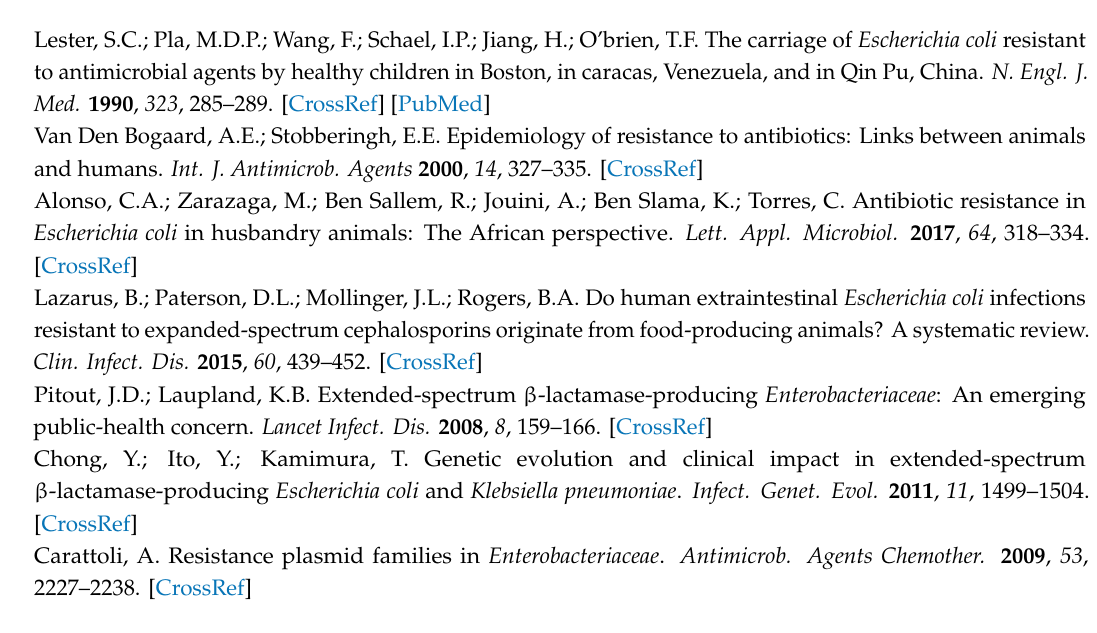
Table S1: Lists of primer sequences and PCR conditions. Figure S1: Xbal -digested pulsed-field gel electrophoresis patterns of bla CTX-M and bla CMY-2 carrying E. coli strains isolated from healthy broiler chickens in Korea. Xbal macrorestriction analysis yielded no DNA banding patterns in five E. coli strain due to constant autodigestion of the genomic DNA during agarose plug preparation, and thus clusters formed by these strains were excluded (ND, not